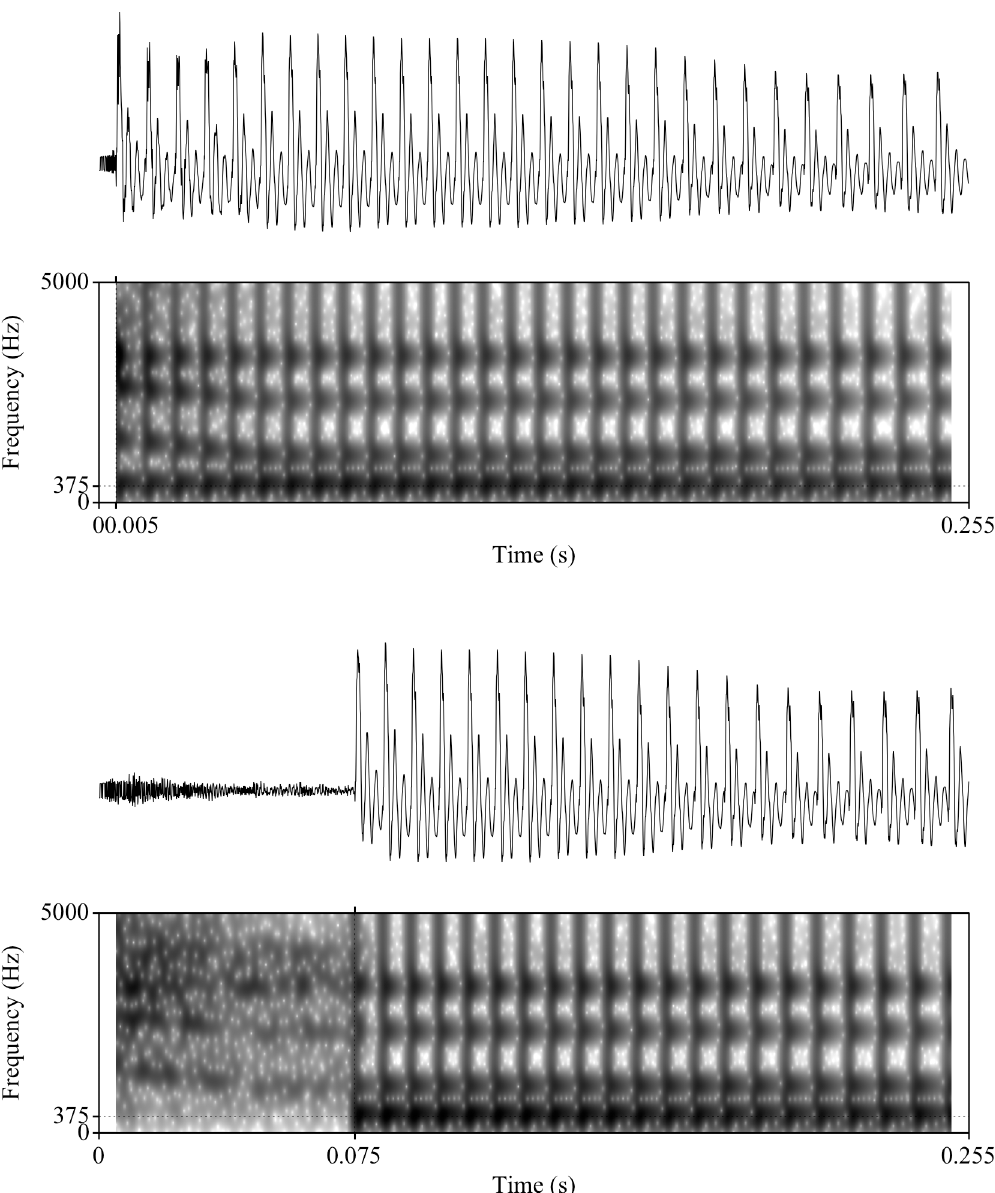
Fig 1. Spectrograms of synthetic speech syllables with low F1 frequency, "da" (upper box) and "ta" (lower box). The F1 frequency for both syllablesat the onset of voicingis 375 Hz. Both stimuli are 255 ms in duration. fourteen acrylic cages were placed in a different room from the rest of the bird population. This room contained white noise machines designed to mask any outside human speech sounds, which continuously played at a level of approximately 70 dB SPL at all times. 70 dB is about 5 dB above “conversational speaking level” of humans. The white noise was required for any human speech sounds in the hallway to not reach the birds. The walls of this room were lined with sound-attenuating foam attached to large wooden boards for easy cleaning and replacing. This procedure using acrylic cages and speech isolation continued for the duration of the experiment.